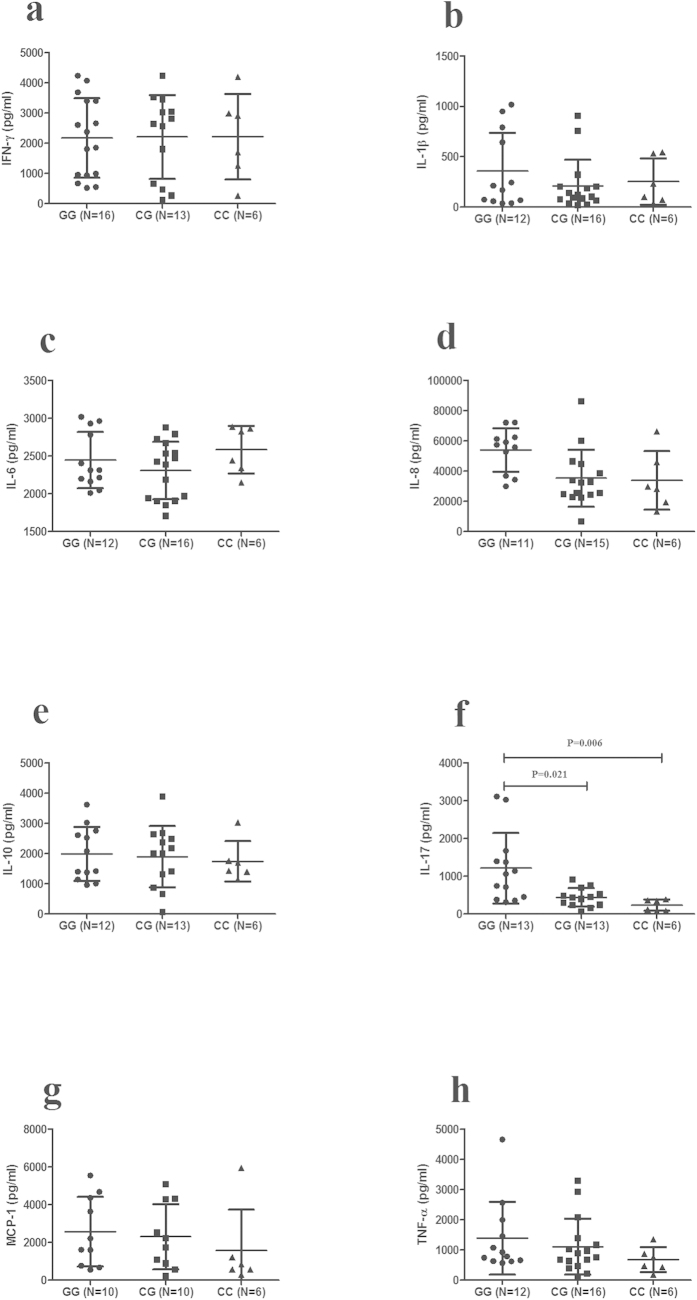
The influence of C5 rs2269067 on cytokines production.Cytokines production of C5 rs2269067 with different genotype cases. The levels of IFN-γ (a), IL-1β (b), IL-6 (c), IL-8 (d), IL-10 (e), IL-17 (f), MCP-1 (g), and TNF-α (h) in PBMCs from normal controls with different genotypes (GG: n = 10–16, CG: n = 10–16, CC: n = 6). Significance was examined by two independent samples Nonparametric test or one-way ANOVA test. Data are shown as mean ± SD.